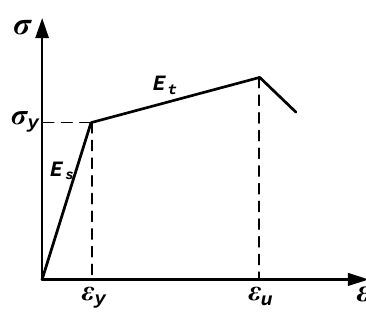
Figure 14. Stress-strain relation of steel grid for the tensile loading.